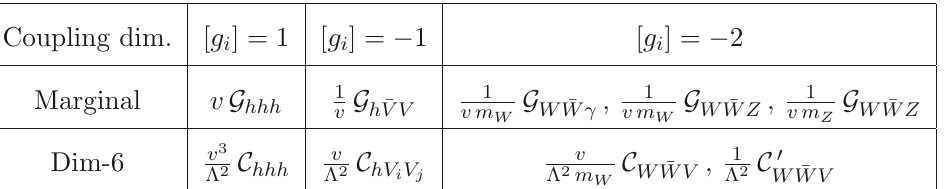
Table 1 . The mass dimension of g i is fixed by the spin/helicities of the 3-point amplitude and we choose to write it as powers of v , m W,Z and Λ times a dimensionless functions (we use for dimension six structures). In order to do the map to the N f = 0 SMEFT we need to write C i the following 3-point amplitudes: hhh , hγγ , hγZ , hW ¯ W , hZ ¯ Z , W ¯ WZ and W ¯ Wγ . The kinematic part is fixed by the massless/massive LG. The symmetries and UV properties of the theory are encoded in the dimensionless functions.